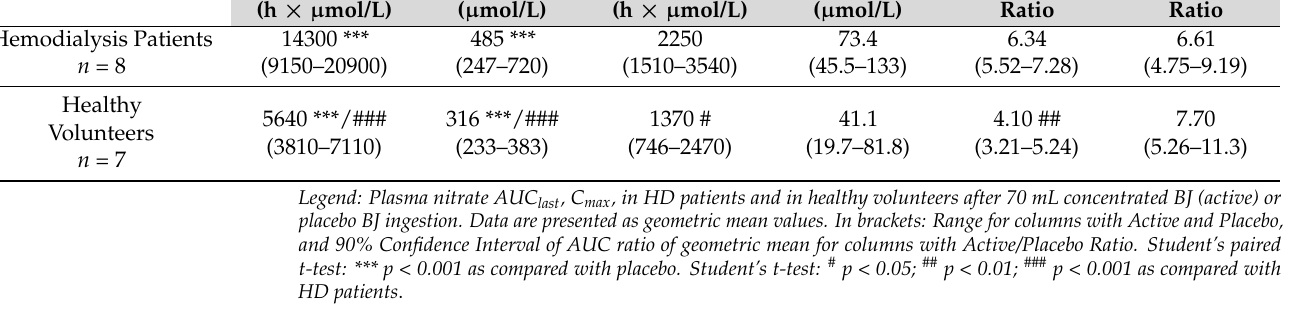
Table 4. Kinetic analysis of plasma nitrate after single ingestion of nitrate-enriched (Active) and nitrate-depleted (Placebo) beetroot juice (BJ) in hemodialysis patients and in healthy volunteers. Active BJ